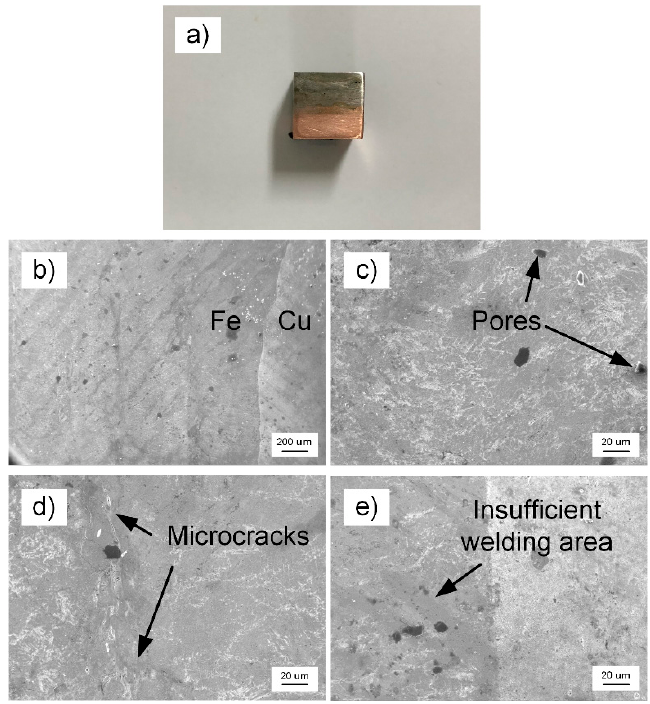
Figure 2. Scanning electron microscopy (SEM) micro-morphology of welded area ( a ) square sample by Electrical Discharge Machining (EDM); ( b ) magnification is 50 times; and, ( c , d , e ) magnification is 500 times.